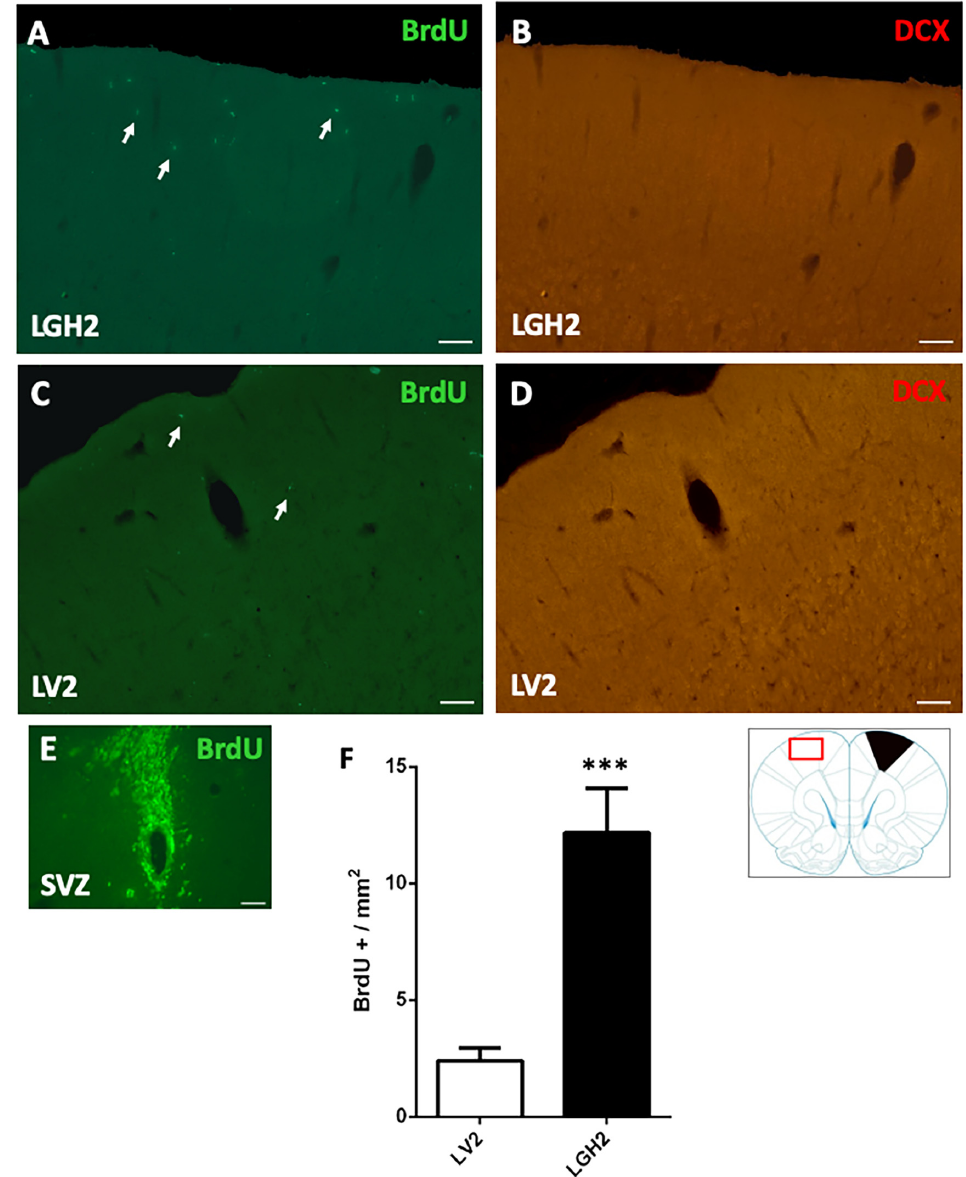
Figure 4. Cell proliferation in the contralateral motor cortex of animals sacrificed at 5 dpi. BrdU and doublecortin (DCX) labeling in the contralateral motor cortex (red rectangle in the scheme) of animals treated with GH ( A , B ) or vehicle ( C , D ), immediately after cortical ablation and sacrificed at 5 dpi. ( E ) positive control of the BrdU labeling in the subventricular zone (SVZ) of the lateral ventricle. Arrows point to some BrdU+ cells. Coronal sections at +2.52 mm from Bregma. Scale bar = 200 µm. ( F ) shows the significant increase in BrdU-labeled cells (mean ± SEM, n = 2) observed in GH-treated animals compared to vehicle-treated animals. The black region indicates where the ablation was produced. *** p < 0.001 (Student’s t -test).